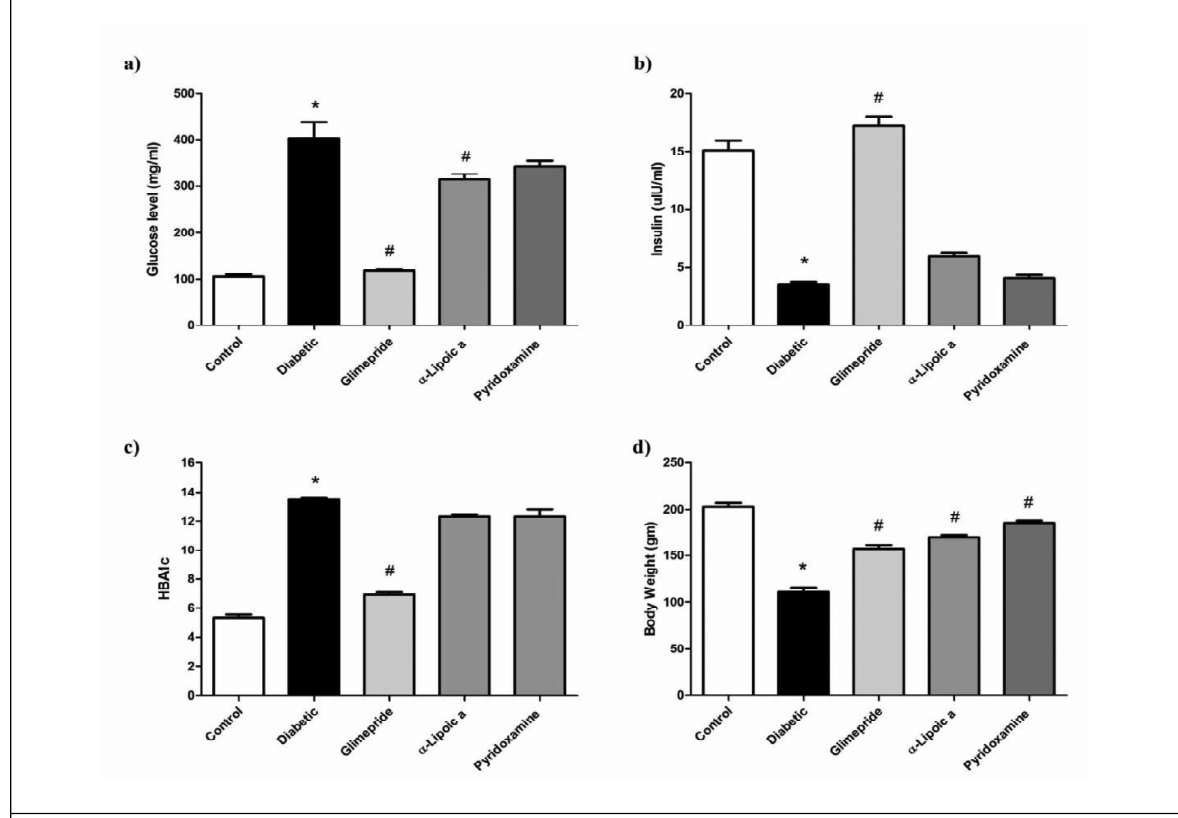
Figure 1: Effect of diabetes induction using STZ and treatment with glimepiride, lipoic acid and pyridoxamine for 8 weeks on: (a) blood glucose, (b) serum insulin, (c) glycated hemoglobin (HbA1c) and (d) body weight Note: Data are presented as mean ± SEM ( n = 6-8); * significantly different from control group, # significantly different from diabetic group at p < 0.05 using One Way ANOVA and Tukey’s post hoc